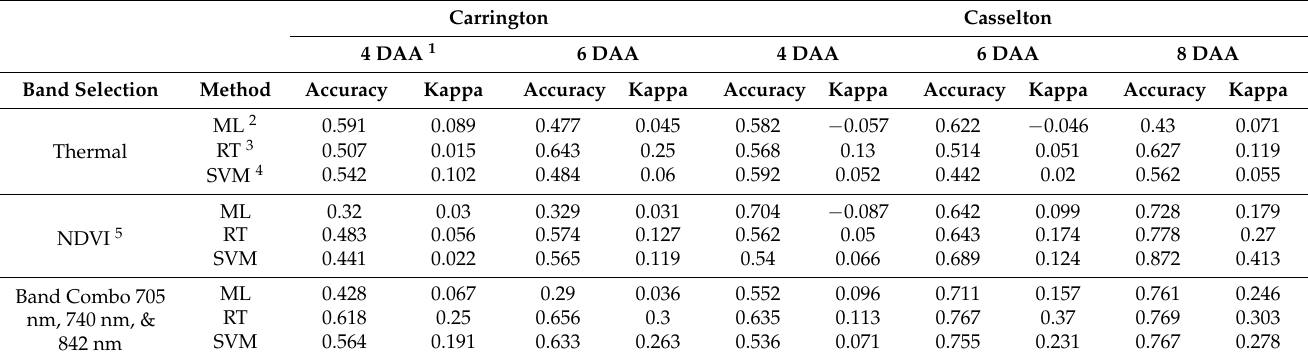
Table 6. Ragweed Classification Performance